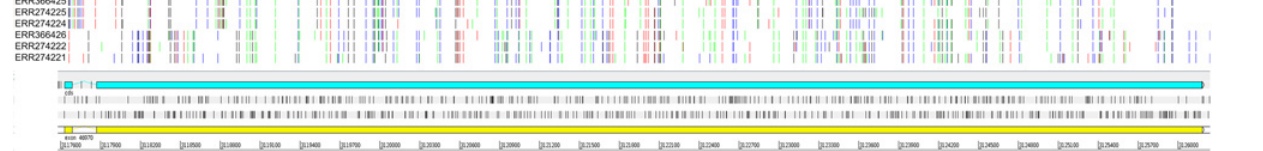
Fig 1. A screen shot of Artemis DNA view comparing six Plasmodium knowlesi genome sequences from patient isolates to the Plasmodium knowlesi H strain reference genome sequence. The P . knowlesi normocyte binding protein xa locus on chromosome 14 is shown. The screen shot shows segregation of the sequences from patient isolates into two groups, (n = 3 in each group) and the dimorphism is clearly